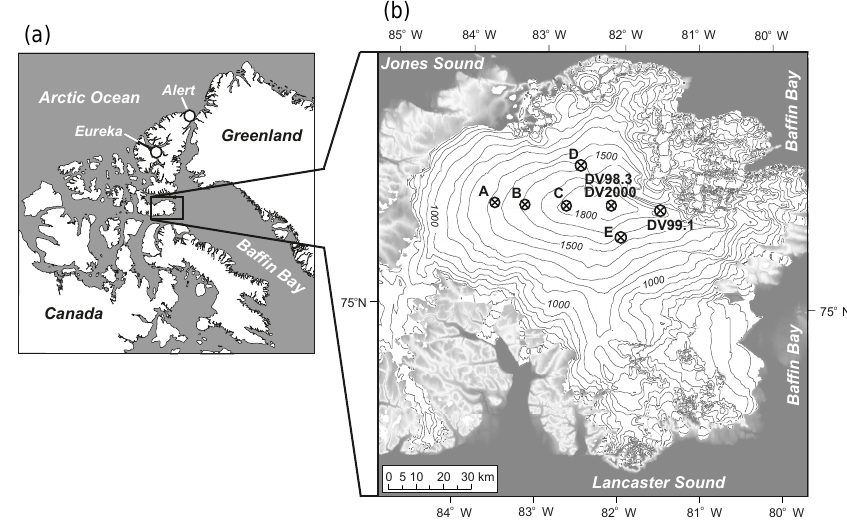
Figure 1. Location map of the Canadian Arctic Archipelago (a) , with enlargement of Devon ice cap (b) . The location of the various ice-core sites mentioned in the text are shown. Sites A to E refer to the shallow core array of Colgan and Sharp (2008). Elevation contours on Devon ice cap are spaced at 100m above sea